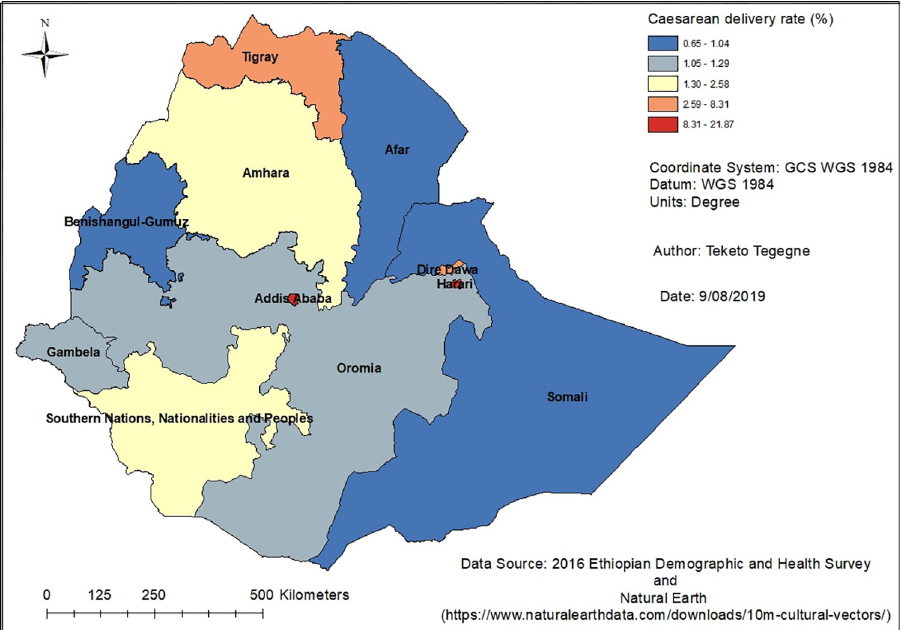
Fig 2. Caesarean delivery use among pregnant women in Ethiopia,